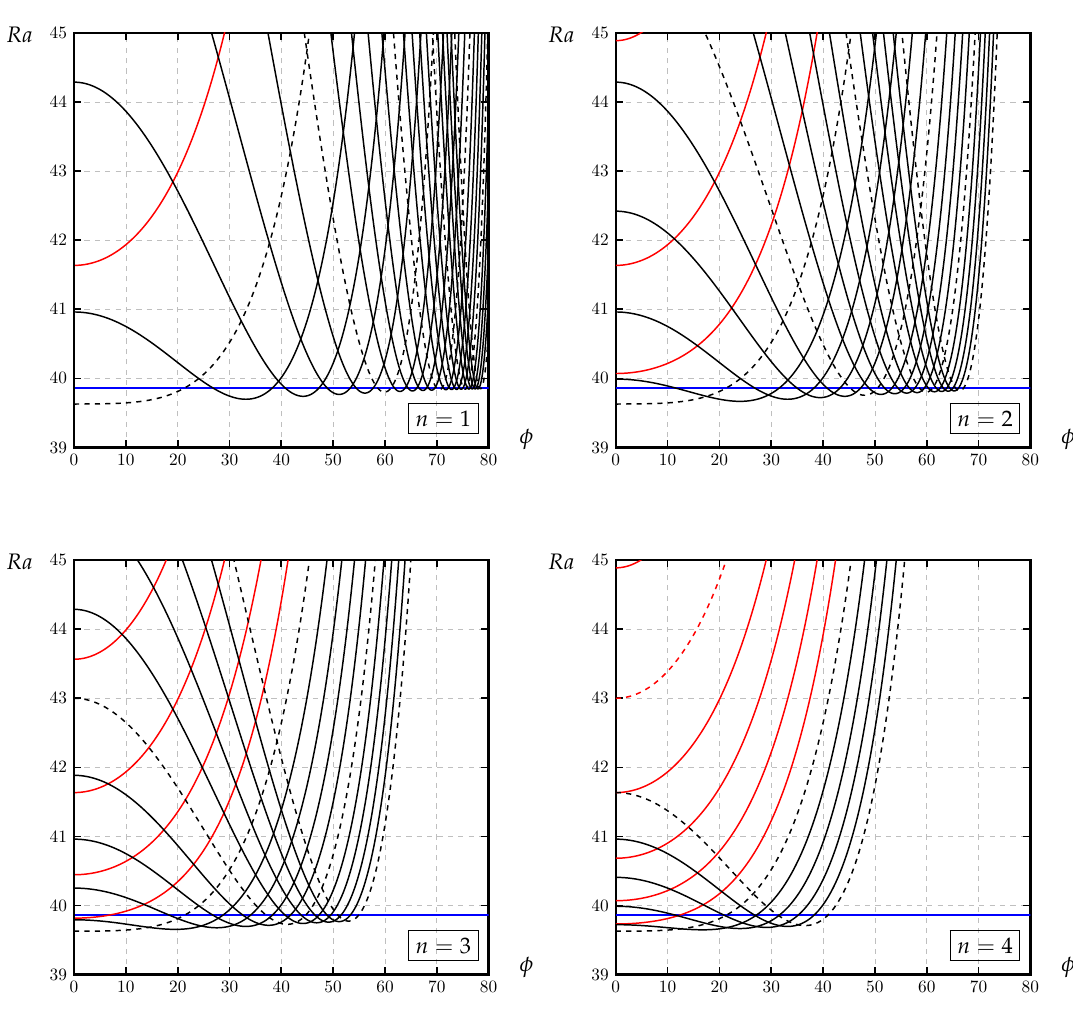
Figure 1. Critical values of Ra against φ for L = 0.6, 0.8 (0.2) · · · 5 when the inclination from the horizontal is α = 5 ◦ and for the n = 1, n = 2, n = 3 and n = 4 modes. The red curves denote those values of L which are less than n . The dotted lines correspond to integer values of L while the rightmost curve is for L = 5. The blue horizontal line corresponds to transverse